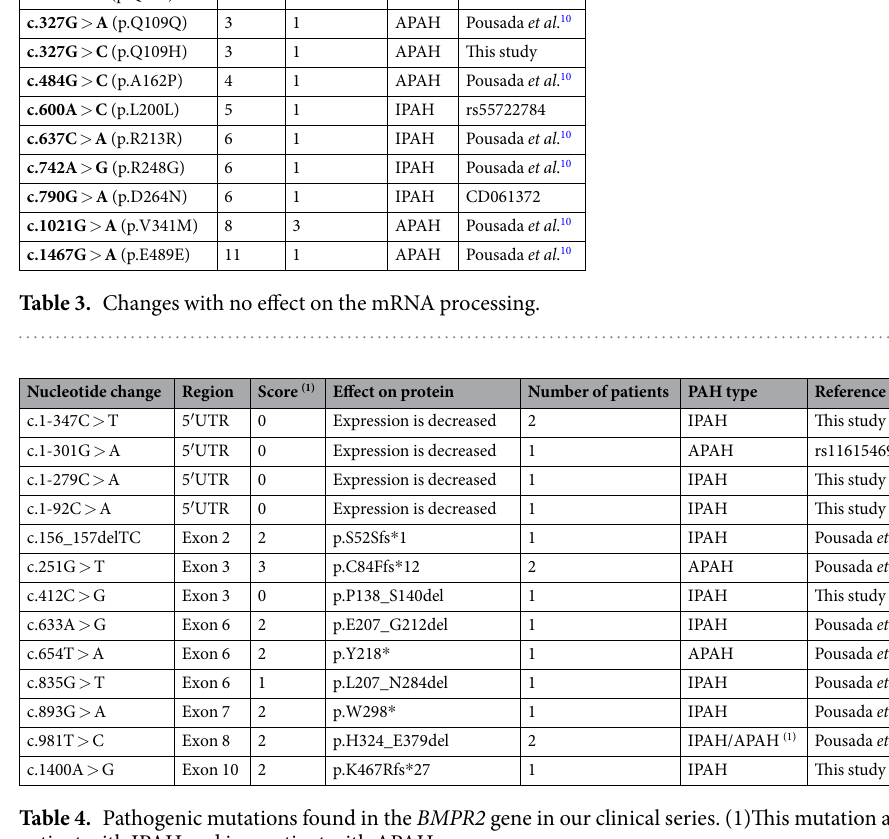
levels. Remarkably, the c.1-279 C > A mutation produced the greatest decrease in the BMPR2 transcriptional activity: 93% (p < 0.0001) (Fig. 8). The c.1-186 A > T change led to a decrease of about 2% with no statistical significance (p = 0.495) (Fig. 4). These pathogenic mutations (c.1-347 C > T, c.1-301 G > A. c.1-279 C > A and c.1-92 C > A) were found in 5 out of 55 patients included in this study. All pathogenic mutations found in the BMPR2 gene in our clinical series are summarized in Table 4. Association with clinical features and hemodynamic parameters. assays. These mutations include synonymous, missense and nonsense mutations located in coding regions and changes located in the 5 ′ UTR region. All of them have been described for the first time by our group, in this paper or in Pousada et al . 10 , except the c.1-301G > A (rs116154690) mutation located in the 5 ′ UTR region. We compared clinical features and hemodynamic parameters among patients with pathogenic changes in the BMPR2 gene and without (Table 1). We found statistically significant differences in systolic pulmonary artery pressure (sPaP; p = 0.042) and 6 minutes walking test (6MWT; p = 0.041): patients carrying a BMPR2 mutation presented with a higher values for this parameter than non-carriers. In addition, individuals harboring muta- tions had a significantly lower age at diagnosis (p = 0.040). Besides, patients with mutations seemed to have worse response to phosphodiesterase-5-inhibitors (p = 0.010). The presence of mutations was unrelated to gender (p = 0.360), mPaP (p = 0.266), PVR (p = 0.553) and cardiac index (CI) (p = 0.588). Clinical or pathogenic muta- tions were seen in 10 patients with IPAH and 6 patients with APAH without statistical differences (p = 0.137), clinical and hemodynamic parameters did not show significant differences between IPAH and